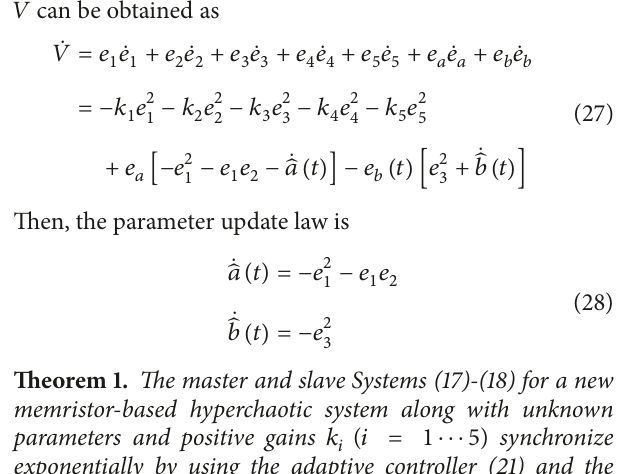
Define the parameters for estimating errors